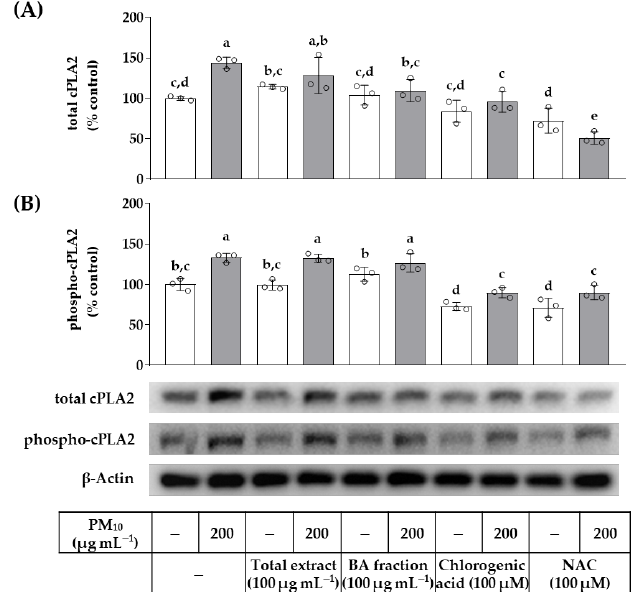
Figure 9. Effects of the total OJ extract, its BA fraction, chlorogenic acid, and NAC on the protein levels of cytosolic phospholipase A2 (cPLA2) and phospho-cPLA2 in HaCaT keratinocytes under basal and PM 10 -exposed conditions. Cells were treated with the total OJ extract (100 μg mL −1 ), BA fraction (100 μg mL −1 ), chlorogenic acid (100 μM), and NAC (100 μM), alone or in combination with PM 10 (200 μg mL −1 ), for 48 h. The protein levels of total cPLA2 ( A ) and phospho-cPLA2 ( B ) were determined by Western blotting and compared to that of β-actin. Representative blots are shown. Data are presented as percentages of the control (mean ± SD, n = 3). Duncan’s multiple range test was performed to compare all group means to each other. Groups that do not share the same lowercase alphabet letters (a–e) have significantly different means at the p < 0.05 level.